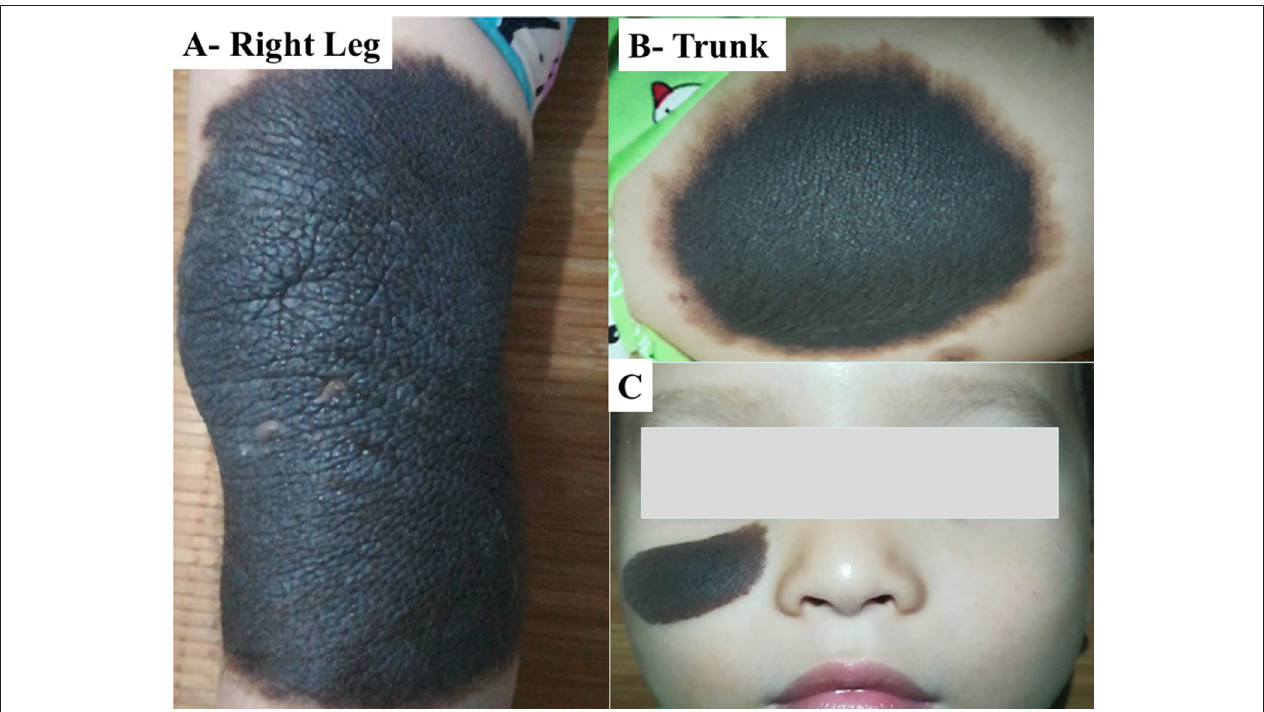
FIGURE 1 | Photos of multiple and GCMN in case-I. CMN was found: (A) on the right leg of about 13cm in diameter, (B) on the trunk, and (C) on the face. The boy had a round face, full cheeks, prominent forehead, hypertelorism, periorbital fullness, short nose, and everted lower lip.